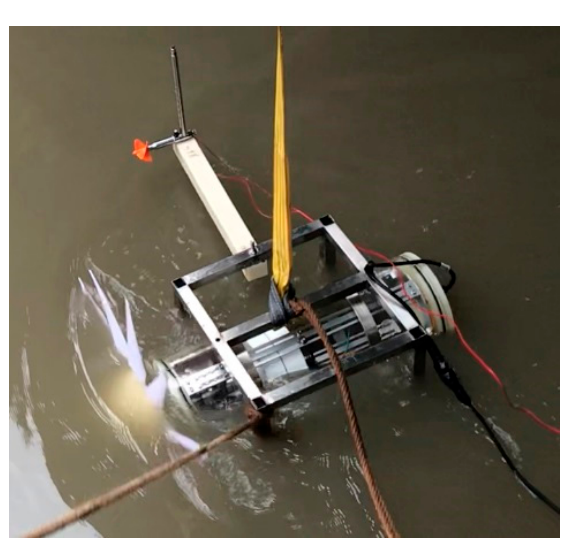
Figure 21. The field test.